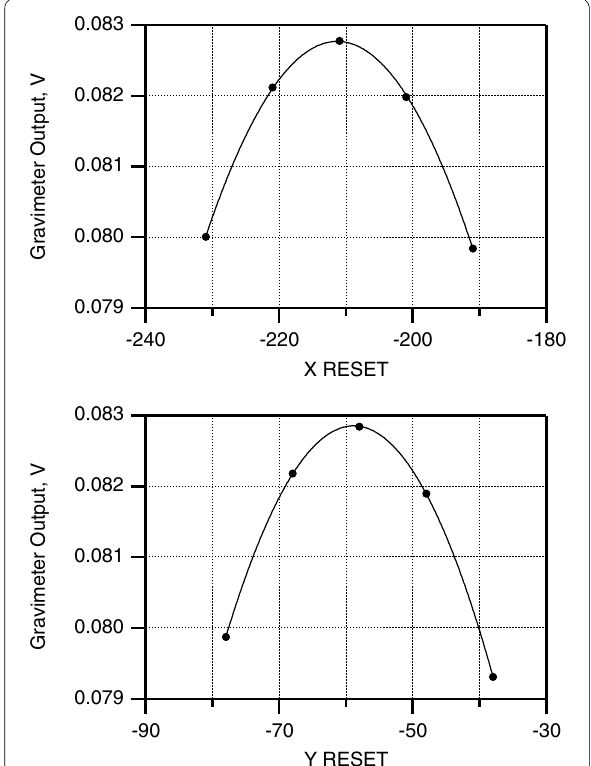
Fig. 4 Results of tilt adjustment for the superconducting